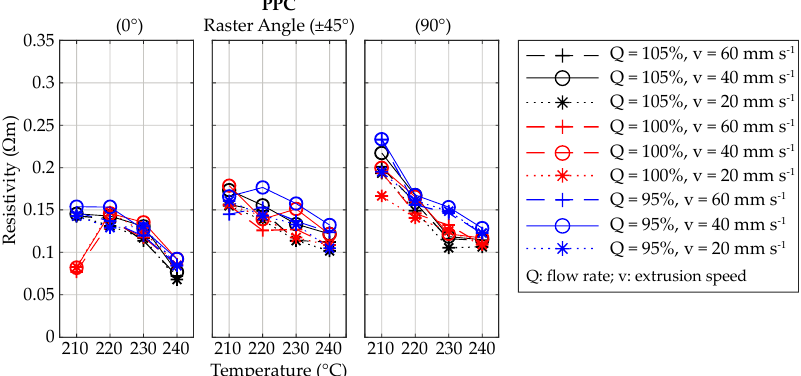
Figure 9. Dependencies of the resistivity of PPC regarding temperature, extrusion speed and flow rate structured by raster angle.